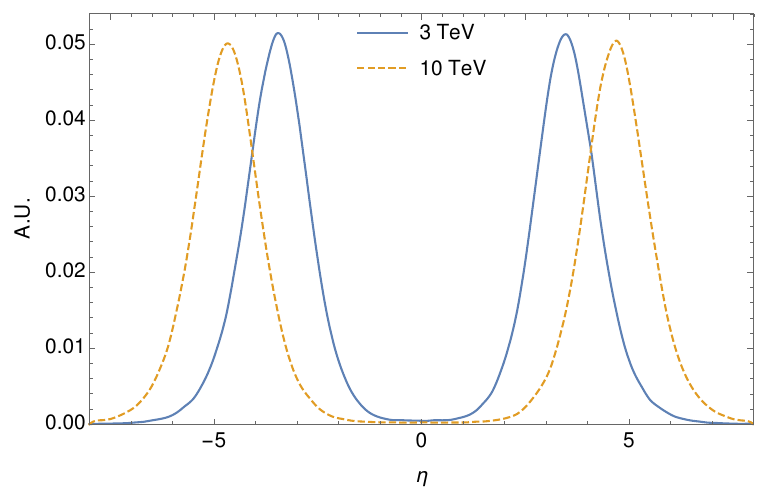
Figure 2 . The normalised pseudorapidity distributions of the forward muons from ZZ fusion single Higgs production at 3 and 10